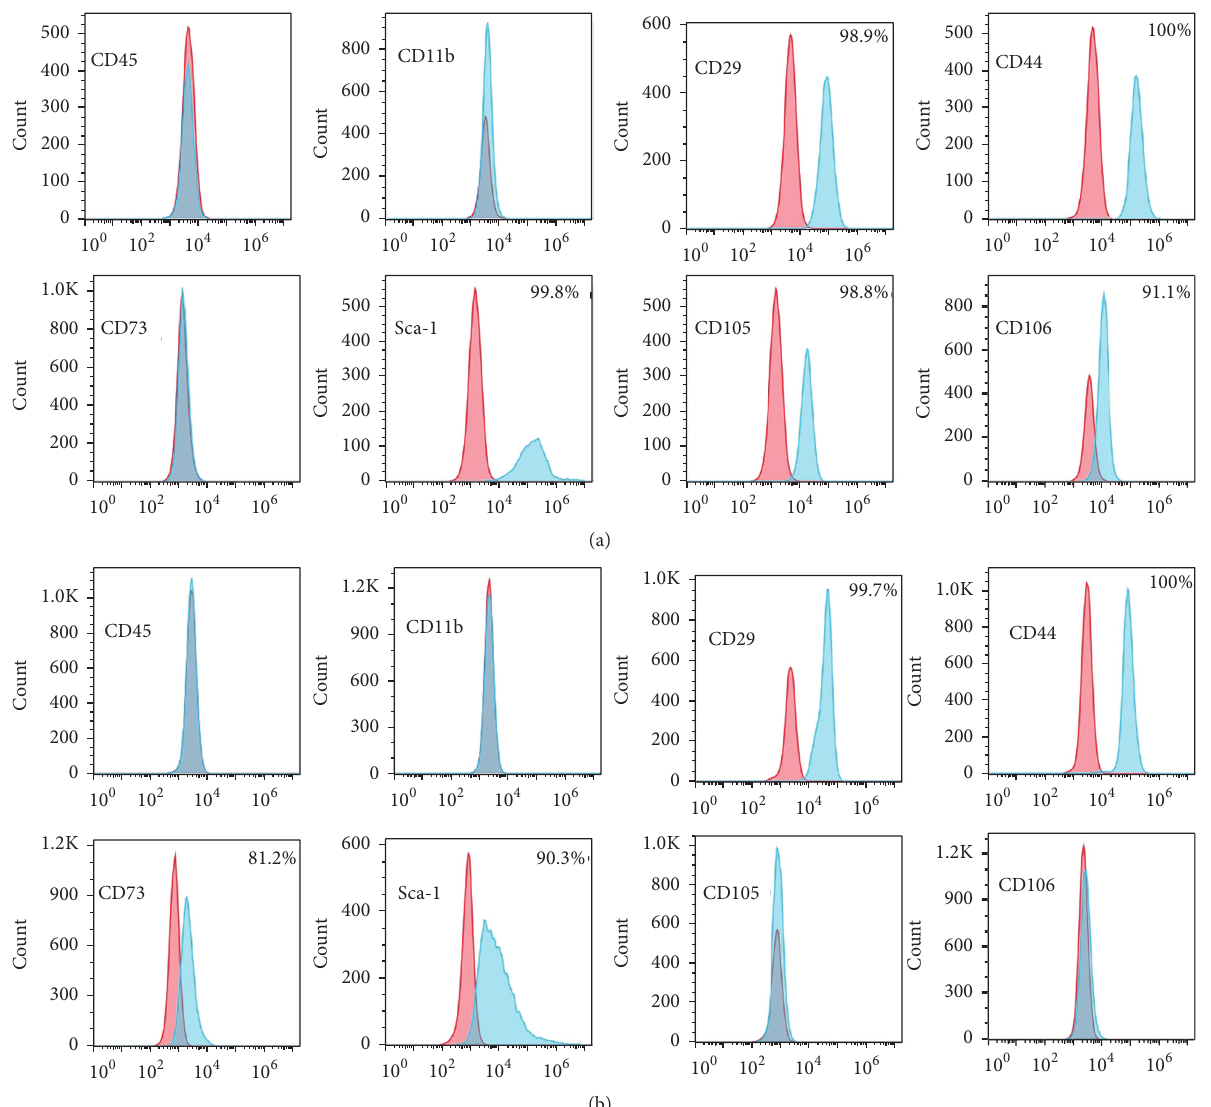
Figure 3: Flow cytometry of MSC-associated antigens in aortic mesenchymal progenitor cells, mAo, and bone marrow-derived mesenchymal progenitor cells, D1. Flow cytometry was performed to detect CD45, CD11b, CD44, CD73, Sca-1, CD105, and CD106 surface antigens in mAo (a) and D1 (b)